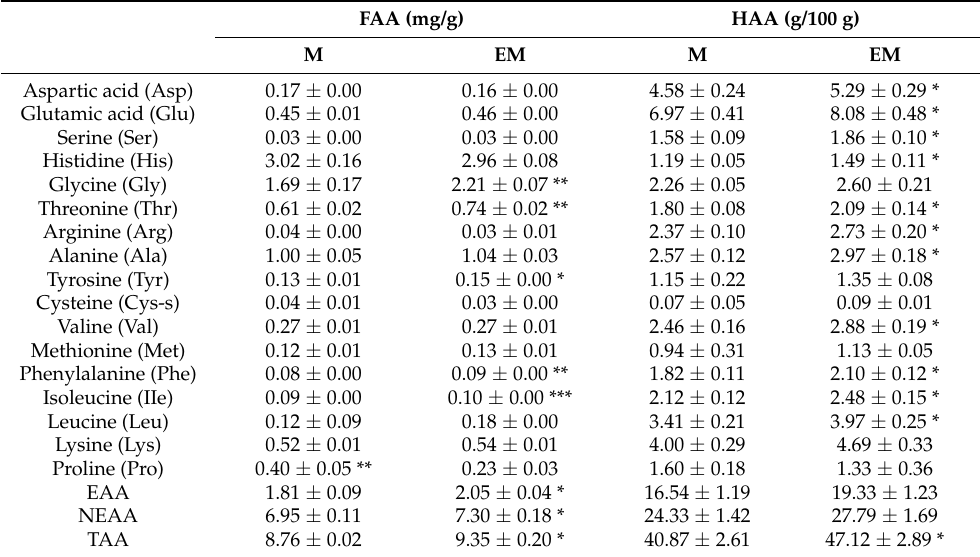
Table 4. Amino acid profile ( n =